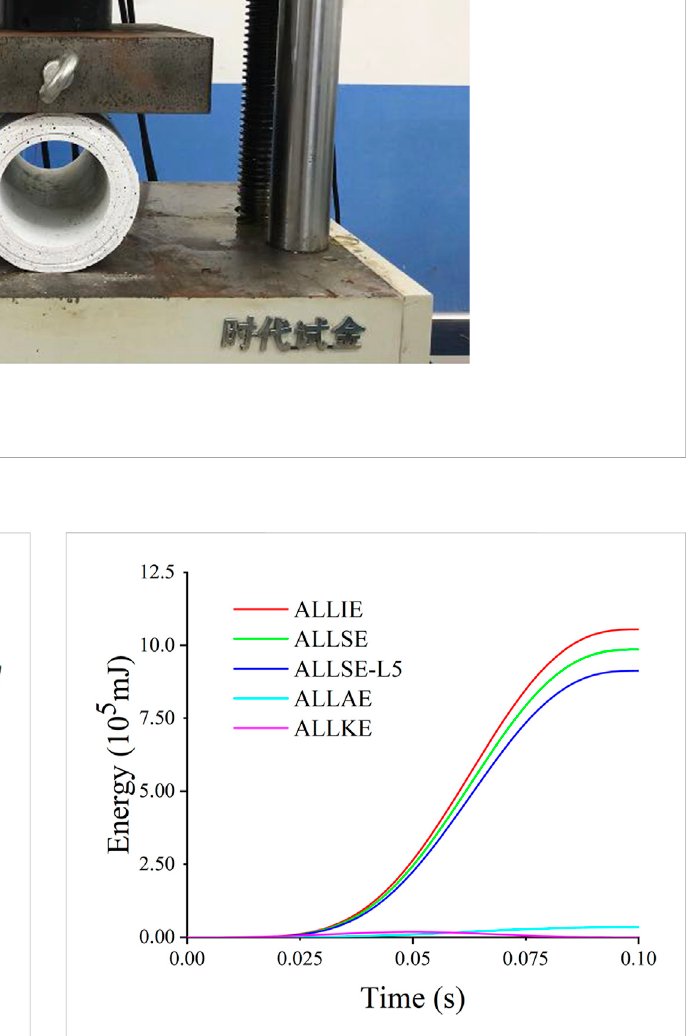
FIGURE 5 Energy time history curves of the fi bre reinforced fl exible